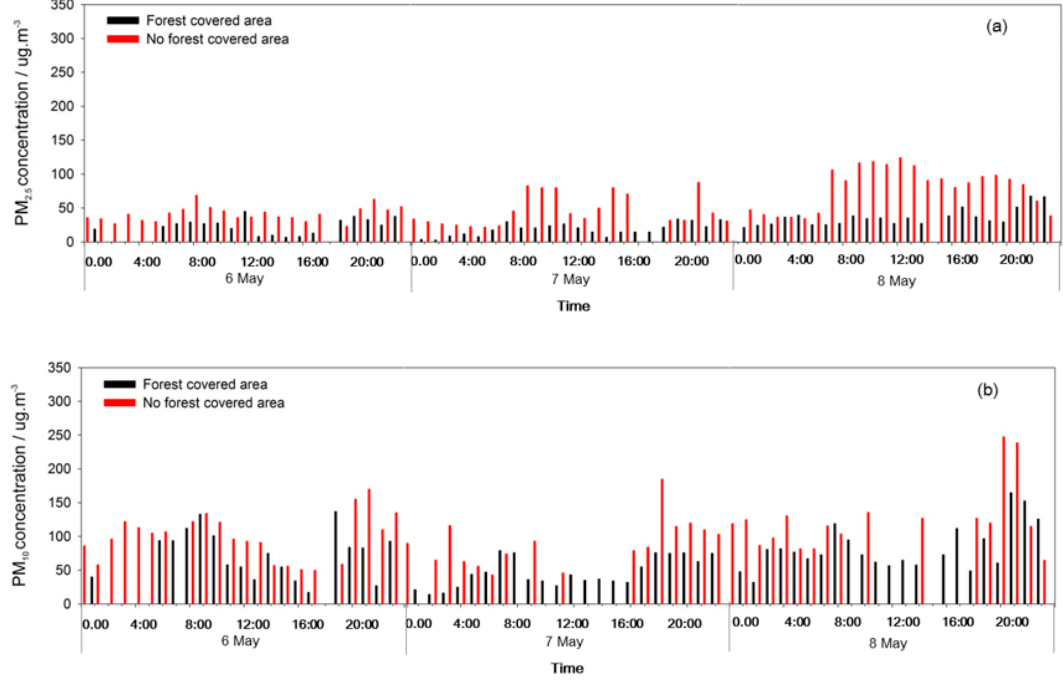
Figure 6. PM 2.5 ( a ) and PM 10 ( b ) concentrations changes during dust storm.